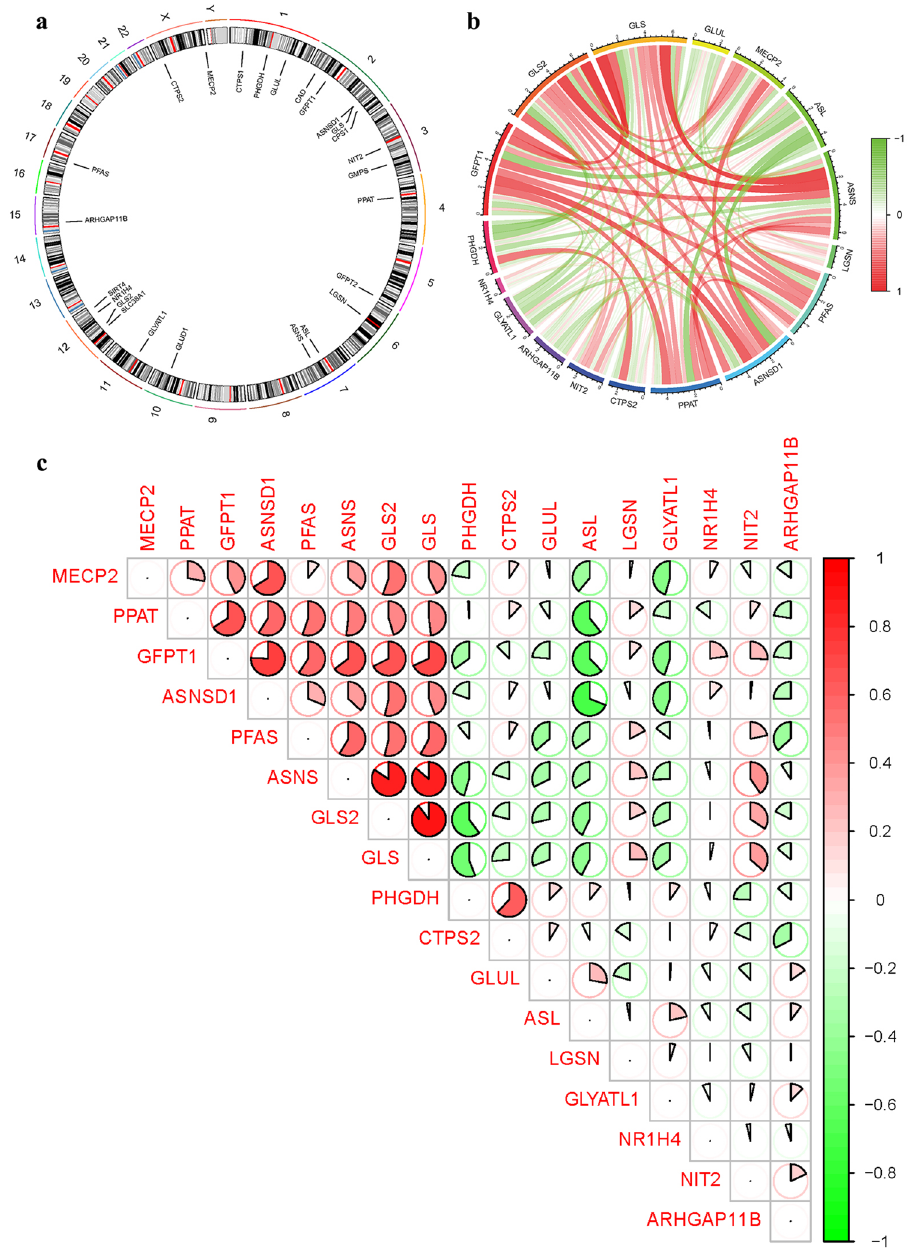
Figure 3. Expression of GlnMgs. ( a ) Expression of GlnMgs on sequences. ( b , c ) The correlation between GlnMgs and related